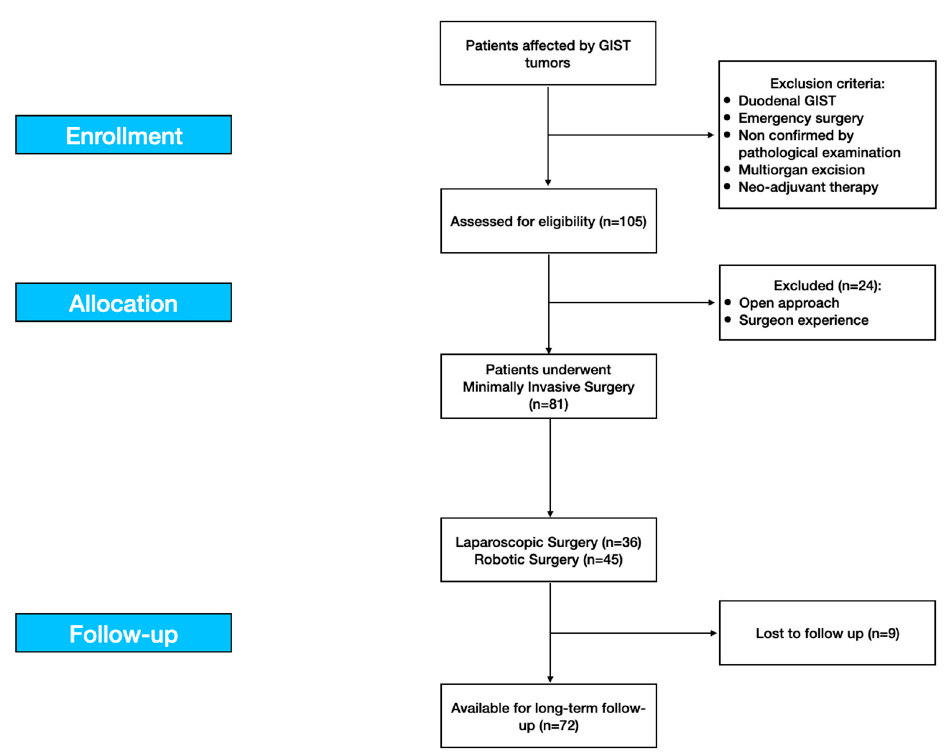
Figure 8. The study flow-chart according to the STROBE statements.